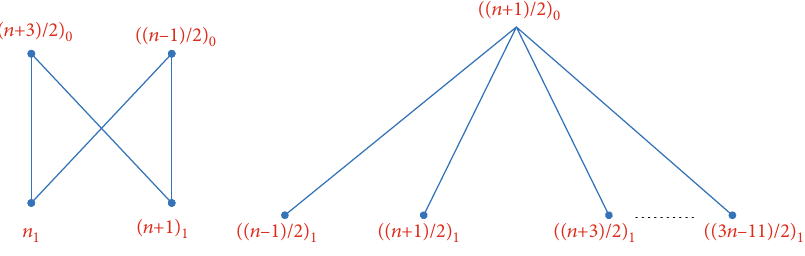
Figure 8: An orthogonal labeling for K